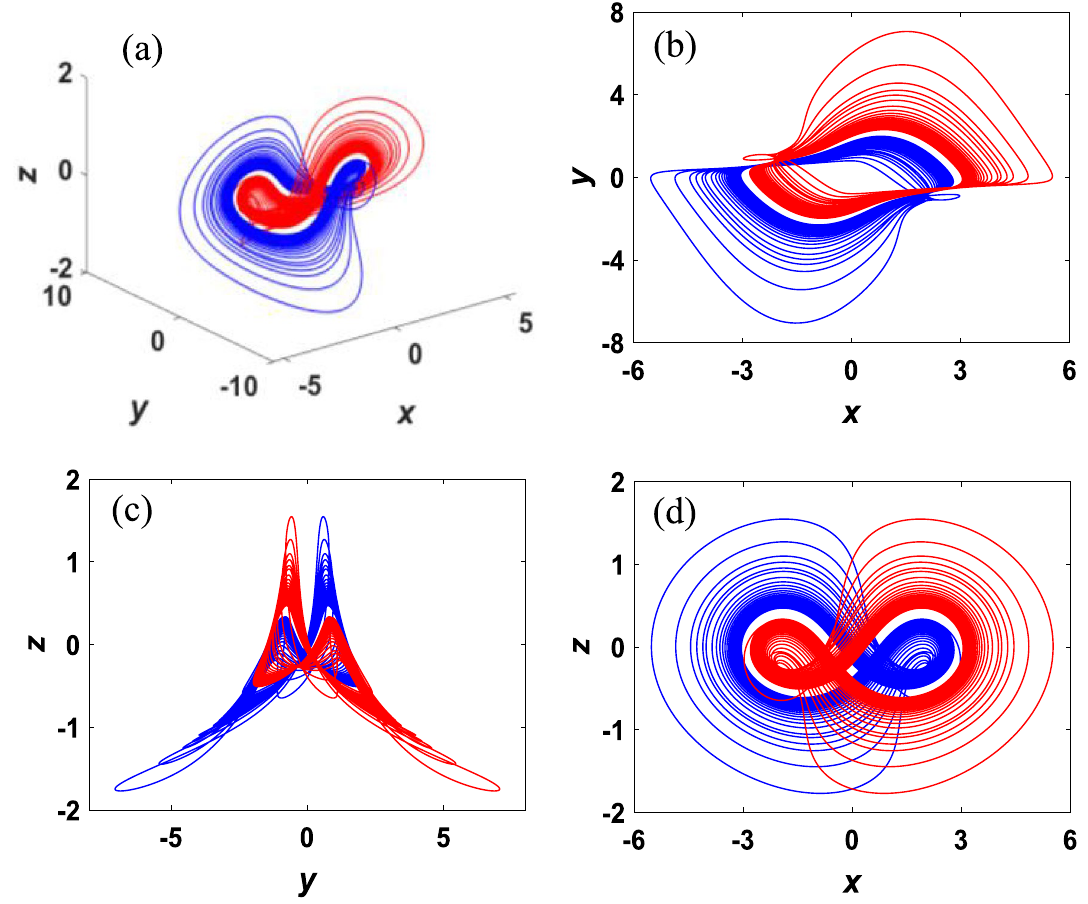
0.26 and initial =